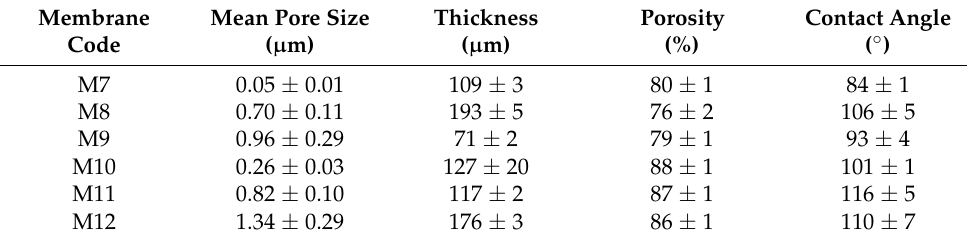
Figure 7. SEM images illustrating the effect of the exposure time to humidity on PVDF-HFP/PolarClean membranes M7–M9 prepared with additives: ( a ) top surfaces; ( b ) bottom surface; ( c ) cross-sections. Table 5. Mean pore size, thickness, porosity and contact angle of the M7–M12 membranes.